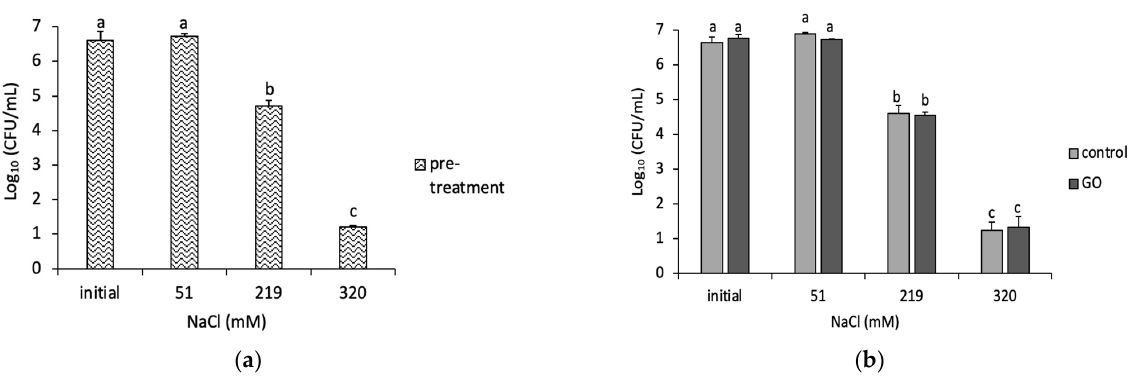
Figure 5. Impact of different osmotic pressure (using NaCl) on P. putida planktonic cells. ( a ) The viability of planktonic cells after exposure to various concentrations of NaCl (pre-treatment). ( b ) The viability of planktonic cells following 24 h exposure to constant NaCl concentrations (51, 219